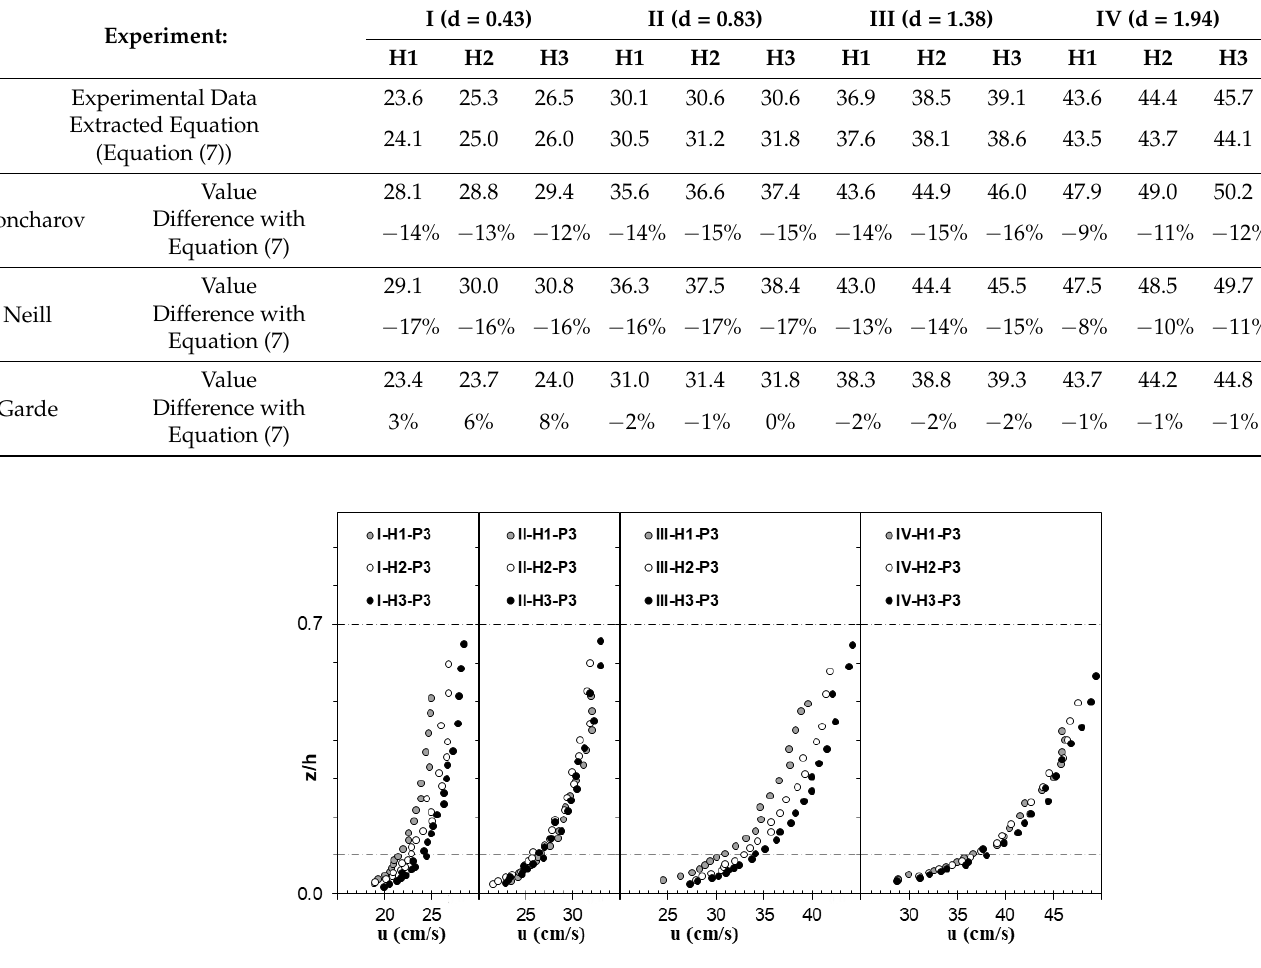
Table 3. Estimation of critical average velocities obtained using Equation (7), compared to results using other equations (cm/s).